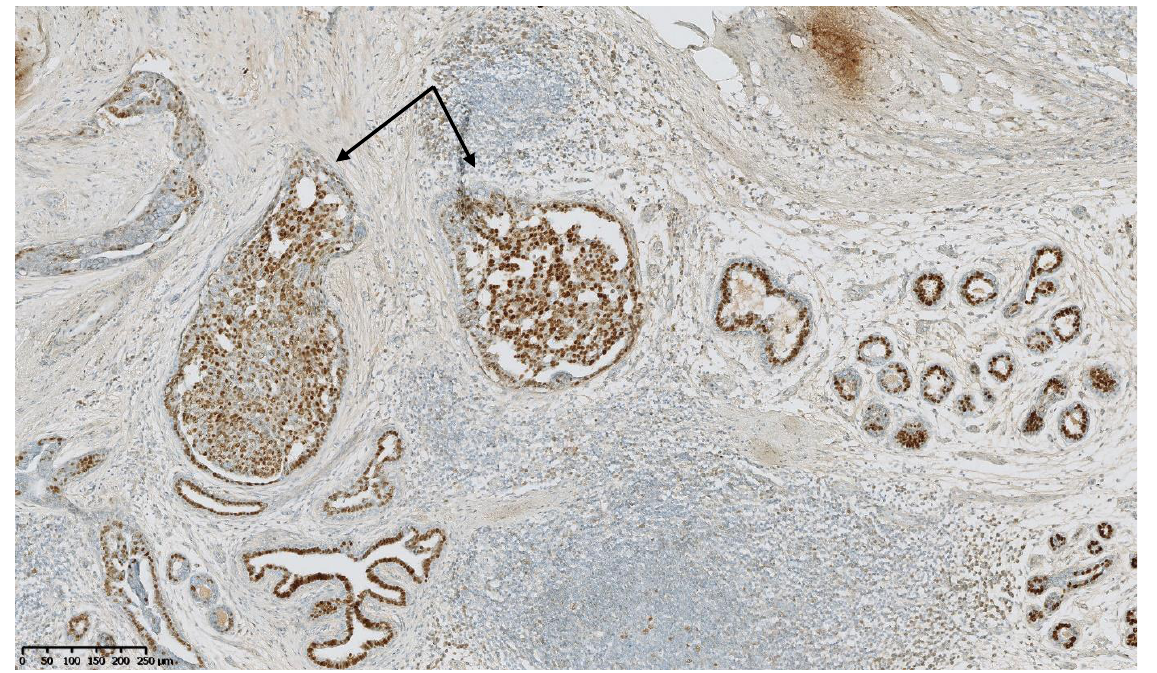
Figure 5. Hematoxylin and eosin staining: at higher magnification, some intraepithelial proliferations are formed by stubby micropapillae with a heterogeneous nuclear population showing no significant cellular atypia, and some are of cribriform architecture with slit-like fenestrations and nuclear streaming, showing no significant cellular atypia either.